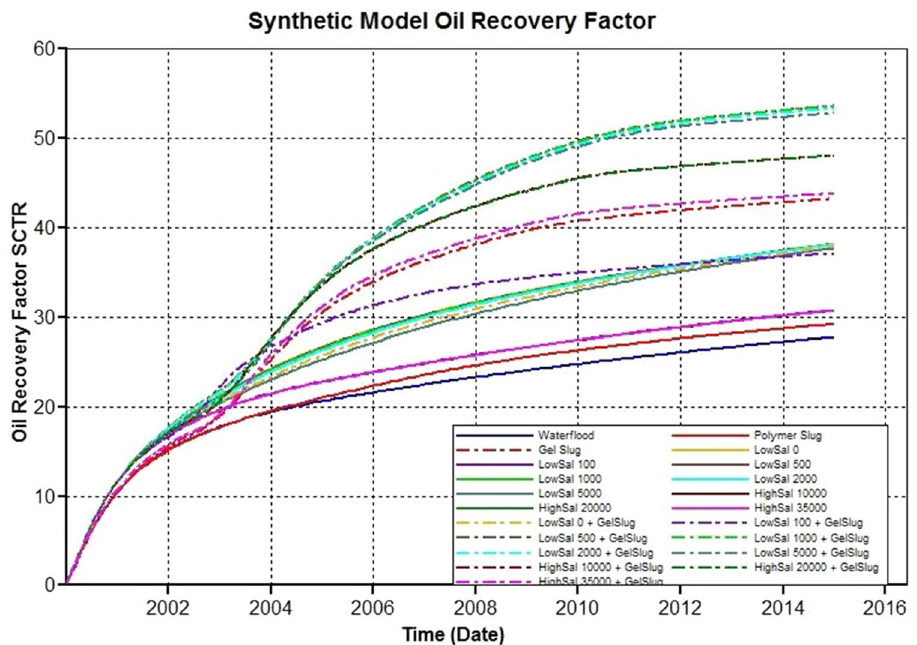
Fig. 11 Oil retention factors for all the models run for the sector of EOR 33